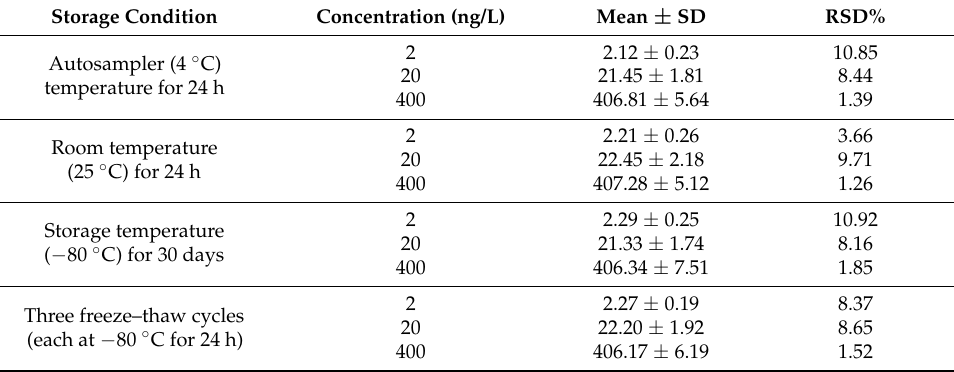
Table 4. Stability of osimertinib in rat plasma under various storage